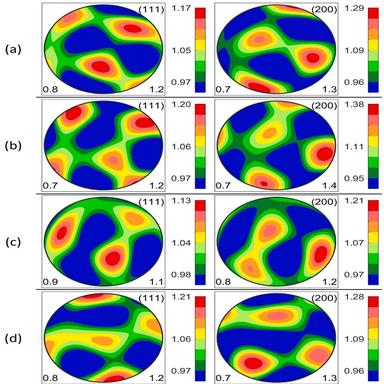
Pole figures in the 111 and 200 orientations for (a) OG1HD, (b) OG2HD, (c) OG3 and (d) OG4.